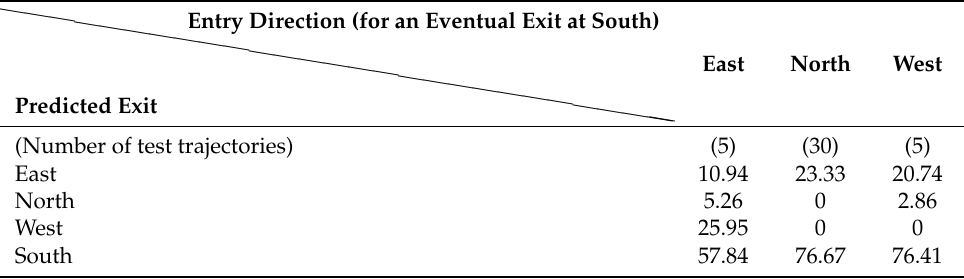
Table 4. Expansion of Table 2 (Column 4) based on entry direction of test trajectories—values in